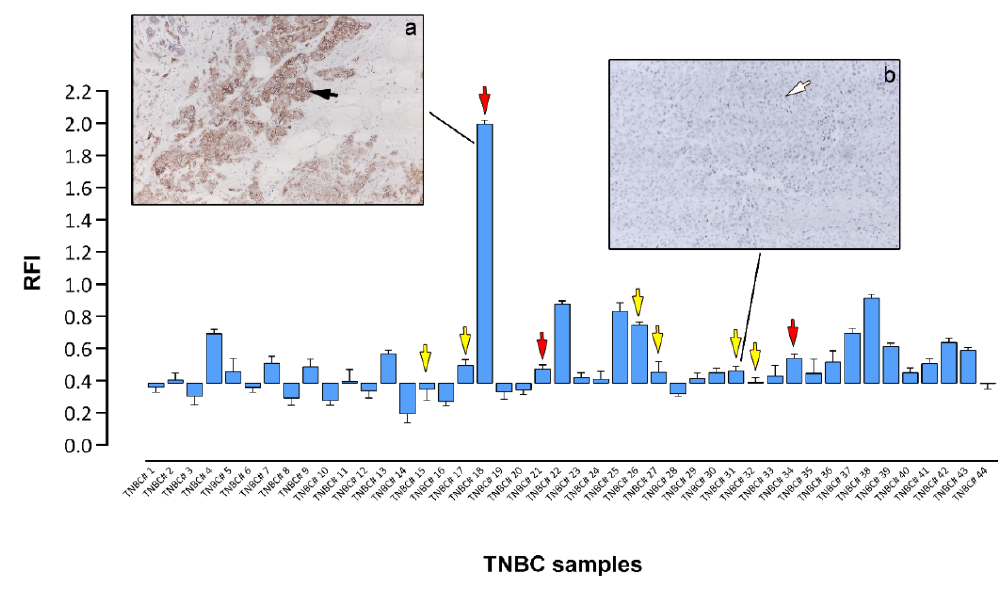
Figure 4. Expression of c-Kit in TNBC samples. Normalized RPPA values for c-Kit were plotted using as baseline value the relative fluorescence intensity (RFI) values of samples found negative by IHC analysis. IHC images of samples stained for c-Kit and showing strong (black arrow, subpanel a ) or no expression (white arrow, subpanel b ) of c-Kit are presented for illustration purposes. Sequenced samples are indicated by arrows (yellow arrows no mutations detected, red arrows oncogenic mutations present). Magnification, 20 × . Table 1. Mutational Analysis of KIT.